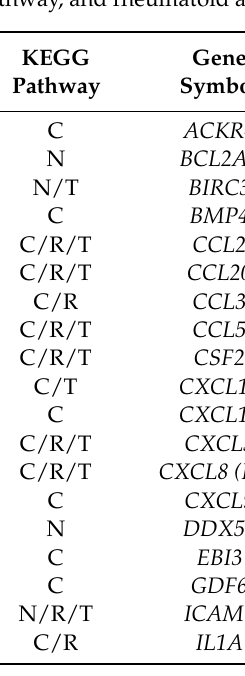
Figure 1. RNA-Seq analyses of DEGs in vehicle, TNF- α , and TNF- α + JD groups. ( A ) Venn diagram analysis of DEGs. The region of overlap among the two circles represents the common DEGs between TNF- α /vehicle and TNF- α + jietacin derivative (JD)/TNF- α datasets. DEGs, differentially expressed genes. ( B ) Bubble diagram of 20 enrichment KEGG pathways of DEGs. Table 1. DEGs in cytokine–cytokine receptor interaction, TNF signaling pathway, NF-kB signaling pathway, and rheumatoid arthritis in the KEGG